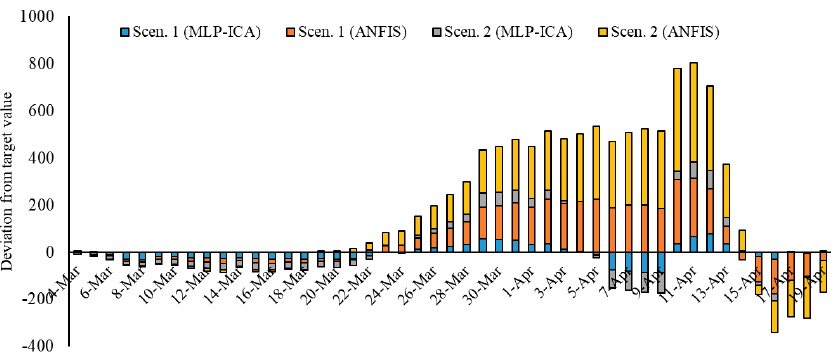
Figure 6. Deviation from target value (Cases).